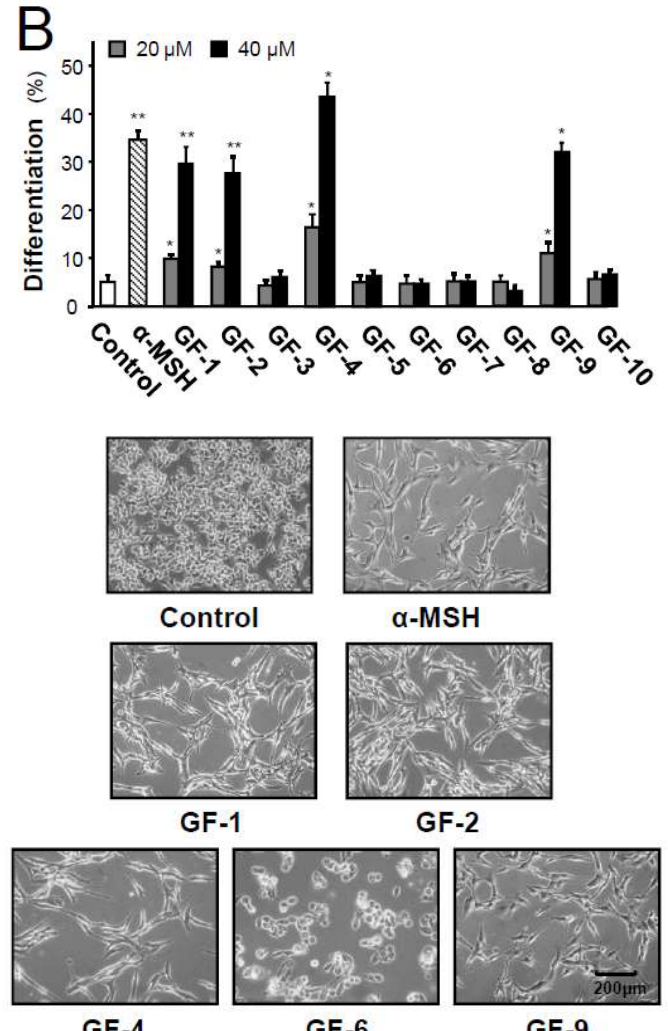
Figure 3. Antiproliferation and differentiation activity of G. uralensis flavonoids on B16-F10 cells. ( A ) Melanoma B16-F10 cells were treated with 10 flavonoids (GF-1–GF-10) at different concentrations or with medium (0.1% DMSO) for 48 h, after which the cells were assayed under MTT assay. IC 50 value was calculated using SPSS statistics software. ( B ) Melanoma B16-F10 cells were treated with 10 flavonoids (GF-1–GF-10) at 20 or 40 μM, positive drug (α-MSH) at 20 nM or medium (0.1% DMSO) for 48 h. At least 150 cells were counted for dendrite longer than 3× cell body, as differentiated cell (upper panel). Data are expressed as percentage of control, as means ± SEM ( n = 3) * p < 0.05, ** p < 0.01, compared with control. Morphological of B16-F10 cells treated with selected flavonoids at 40 μM (lower panel).